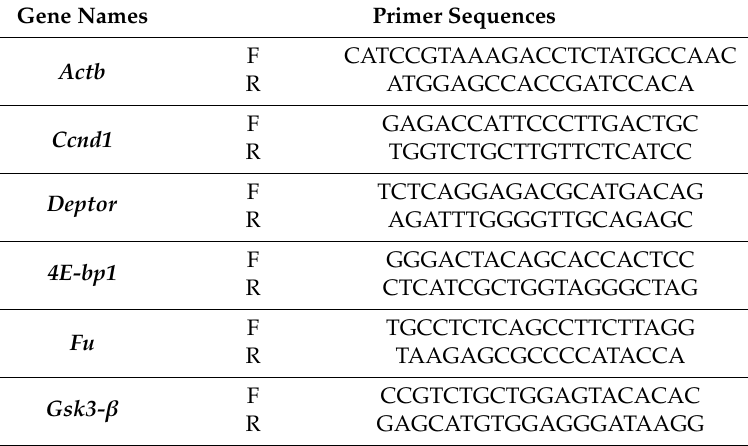
Table 1. Primer sequences for qRT-PCR. f: forward primer; r: reversed primer; the primer for Gli1